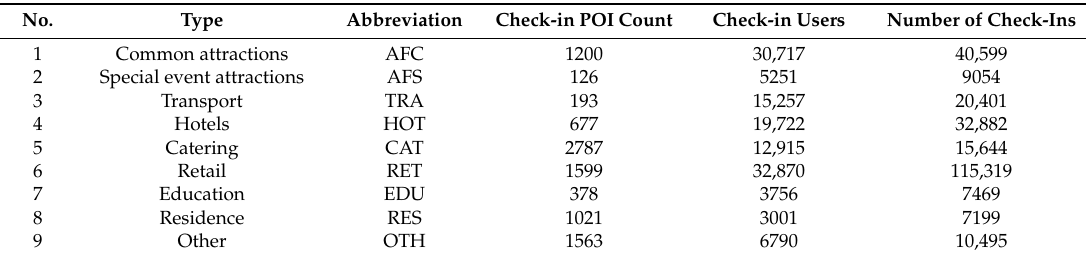
Table 1. Points of interest (POI) categories and check-in data.